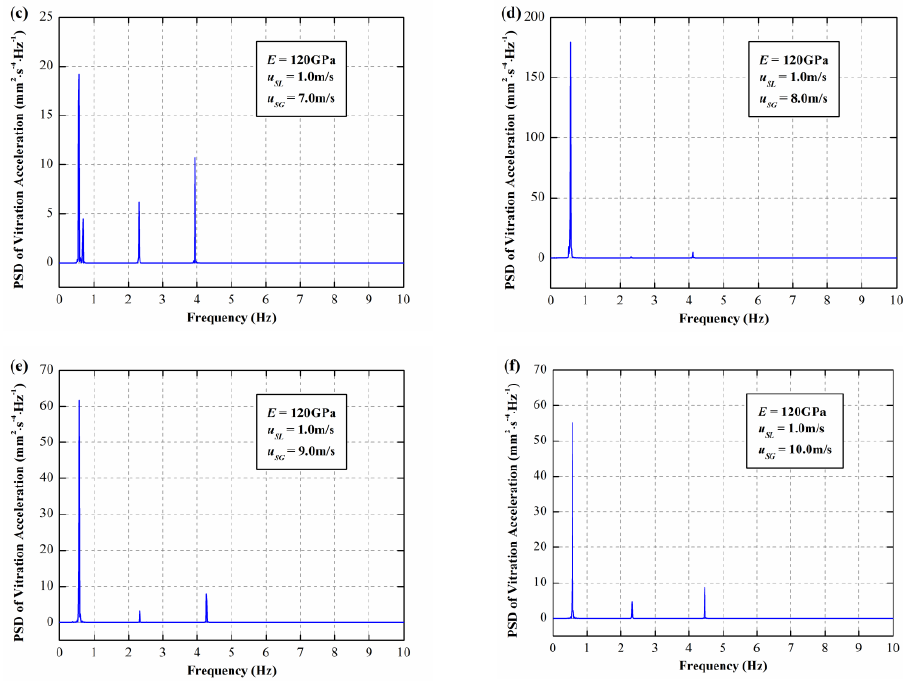
Figure 10. Power spectrum densities of the vibration acceleration for E = 120 GPa and u SL = 1.0 m/s (( a ): u SG = 3.0 m/s; ( b ): u SG = 5.0 m/s; ( c ): u SG = 7.0 m/s; ( d ): u SG = 8.0 m/s; ( e ): u SG = 9.0 m/s; ( f ): u SG = 10.0 m/s).